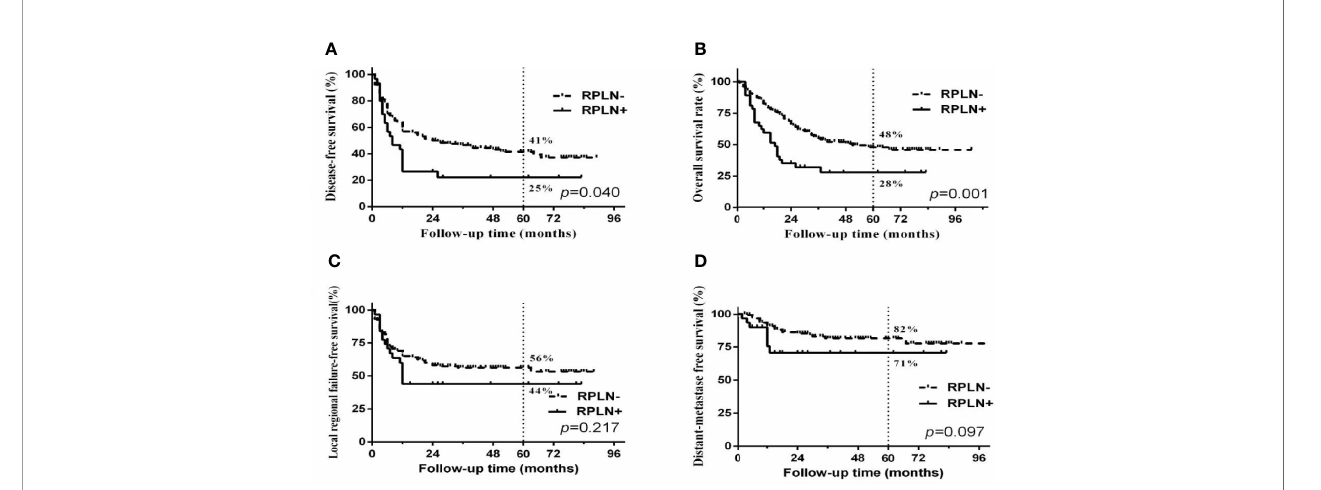
FIGURE 3 | Survival curves between patients with or without RPLN metastasis. (A) disease-free survival; (B) Overall survival; (C) Locoregional failure-free survival; (D) distant-metastasis free survival.